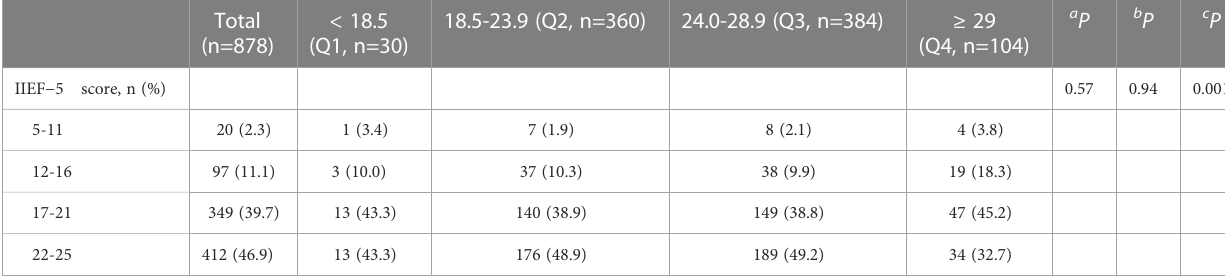
TABLE 4 Frequency distribution of BMI according to IIEF-5